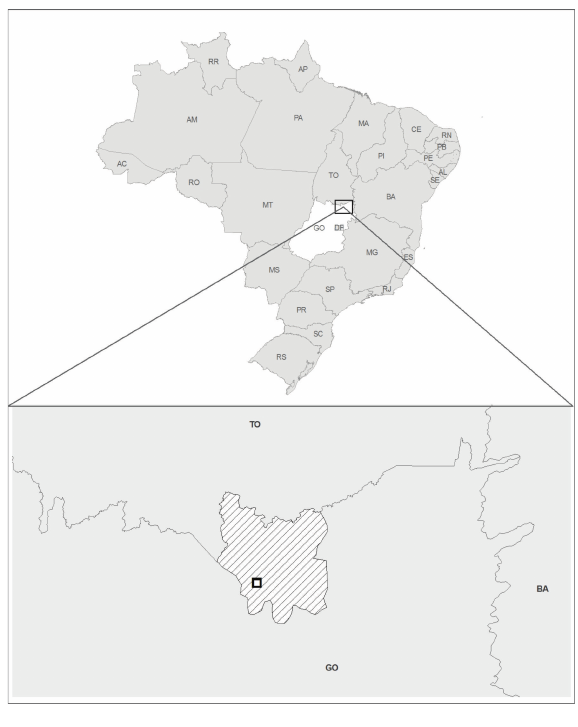
Figure 1: Map of Brazil denoting Goi´as State (GO), the Quilombola Historic Kalunga Site, and the Kalunga Community Engenho II in Cavalcante, GO, central western